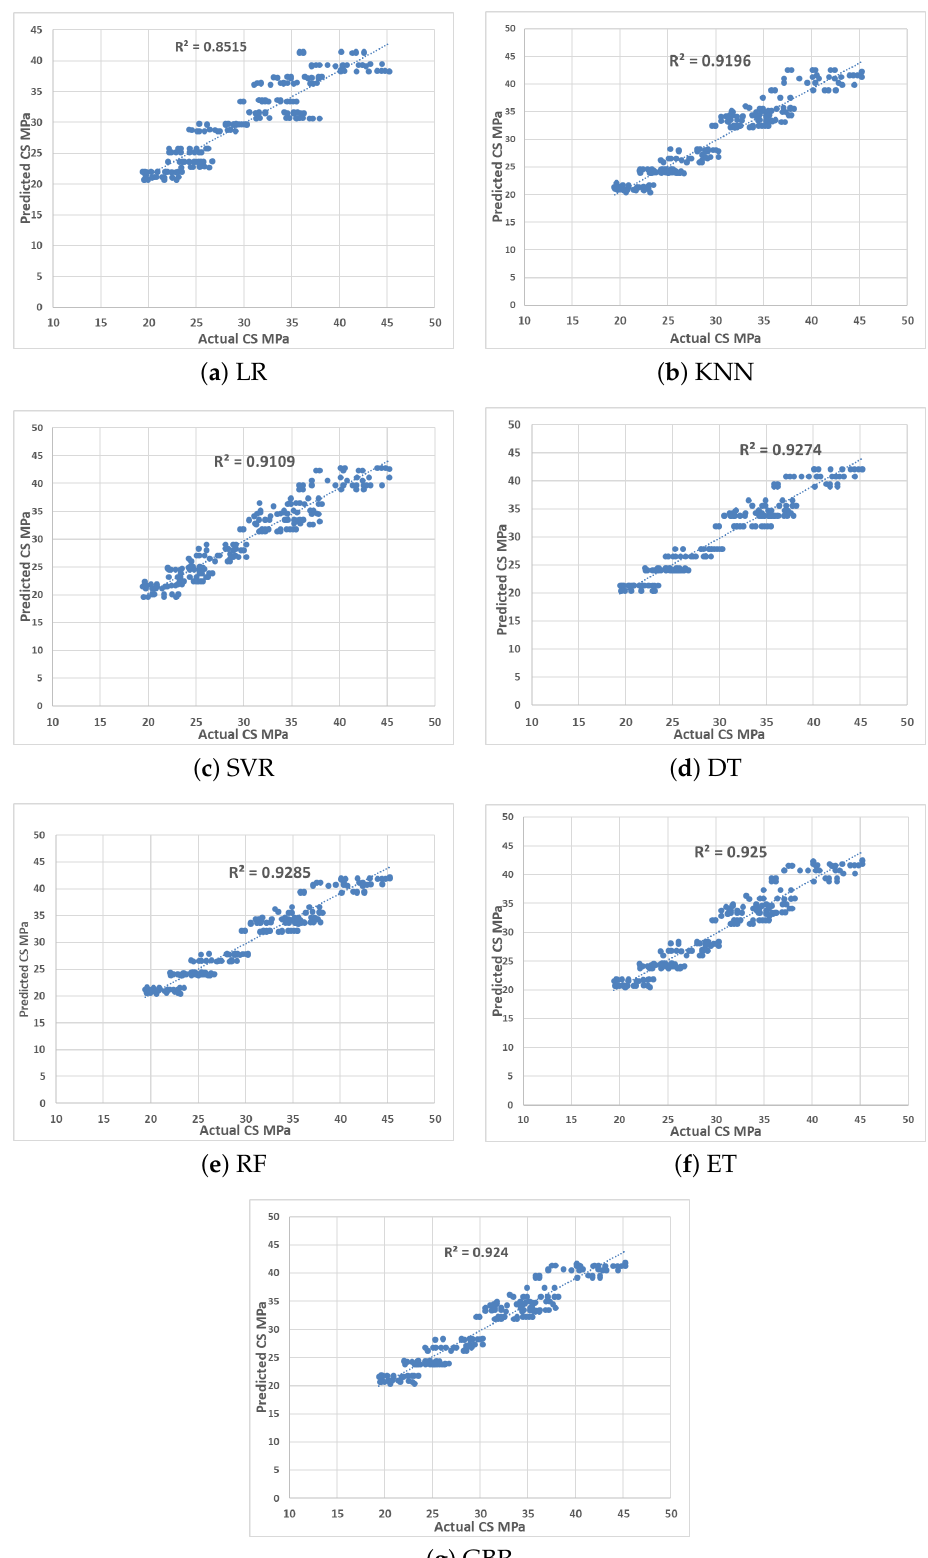
Figure 3. Performance of various ML models in CS